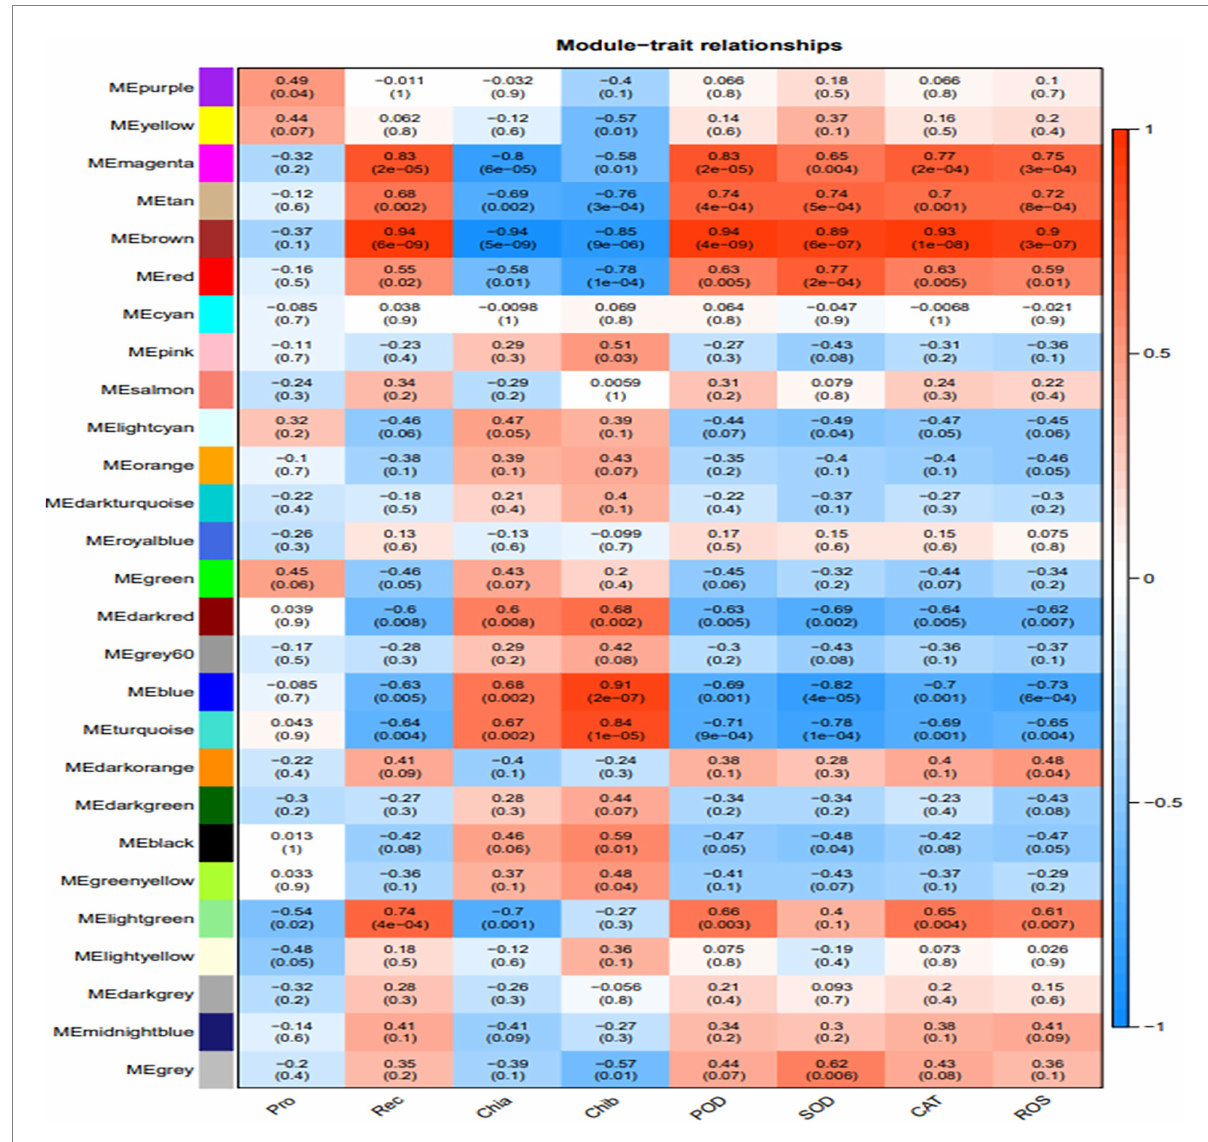
FIGURE 3 Association modules of Helictotrichon virescens phenotypic modules. Each row represents a module, while each column represents a trait. The numbers in the rectangular boxes represent the correlation coefficients and corresponding p values between the modules and